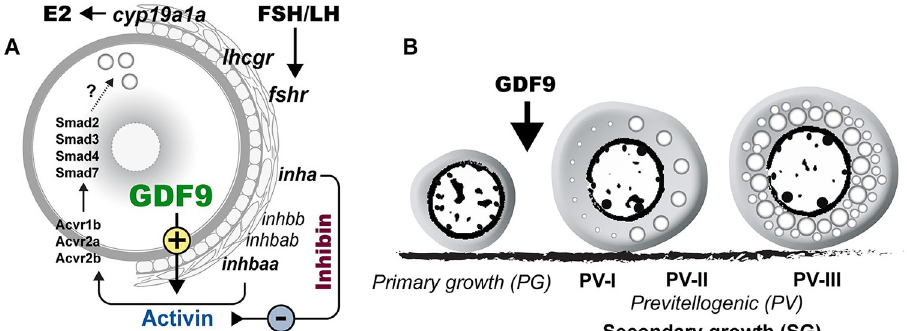
acvr2a / b and smad2/3/3/7 ). (B) GDF9 from the oocyte plays an important gating role in controlling zebrafish follicle activation or PG-PV transition and therefore puberty onset. PV-I, early PV with one single layer of small